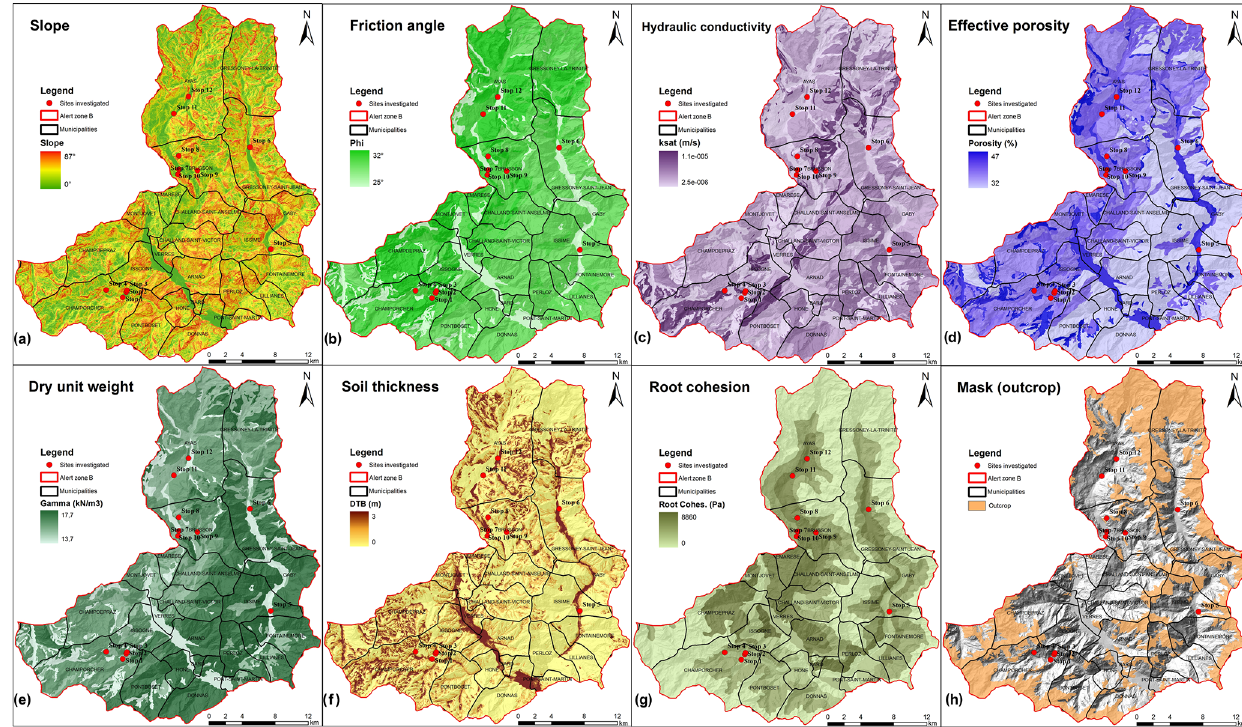
Figure 5. Static input parameters for HIRESSS model: (a) slope gradient, (b) friction angle, (c) hydraulic conductivity, (d) effective porosity,